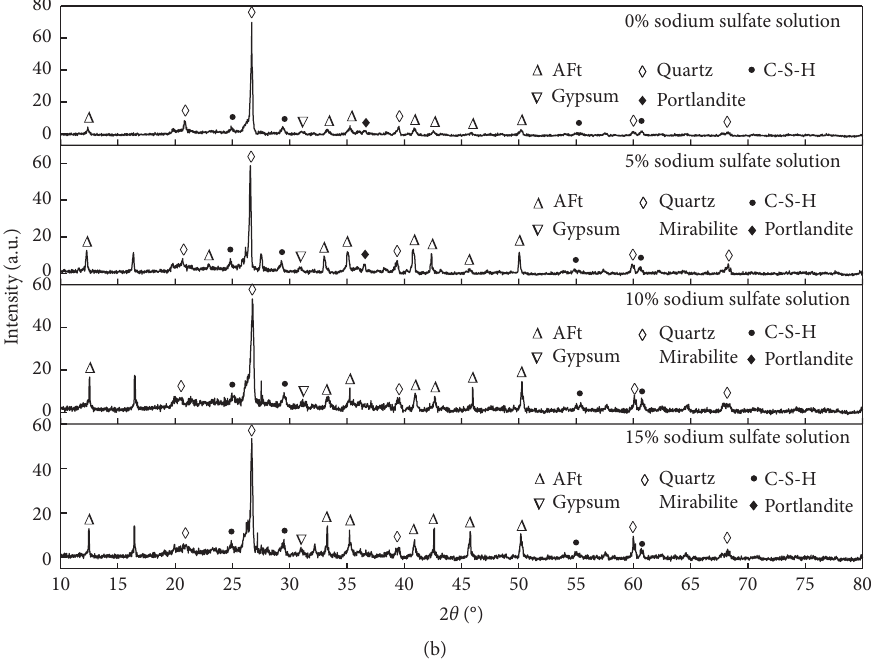
Figure 10: XRD patterns of CGFB samples immersed in 0–15% sodium sulfate solutions at the (a) third and (b) fifteenth drying-wetting cycles.